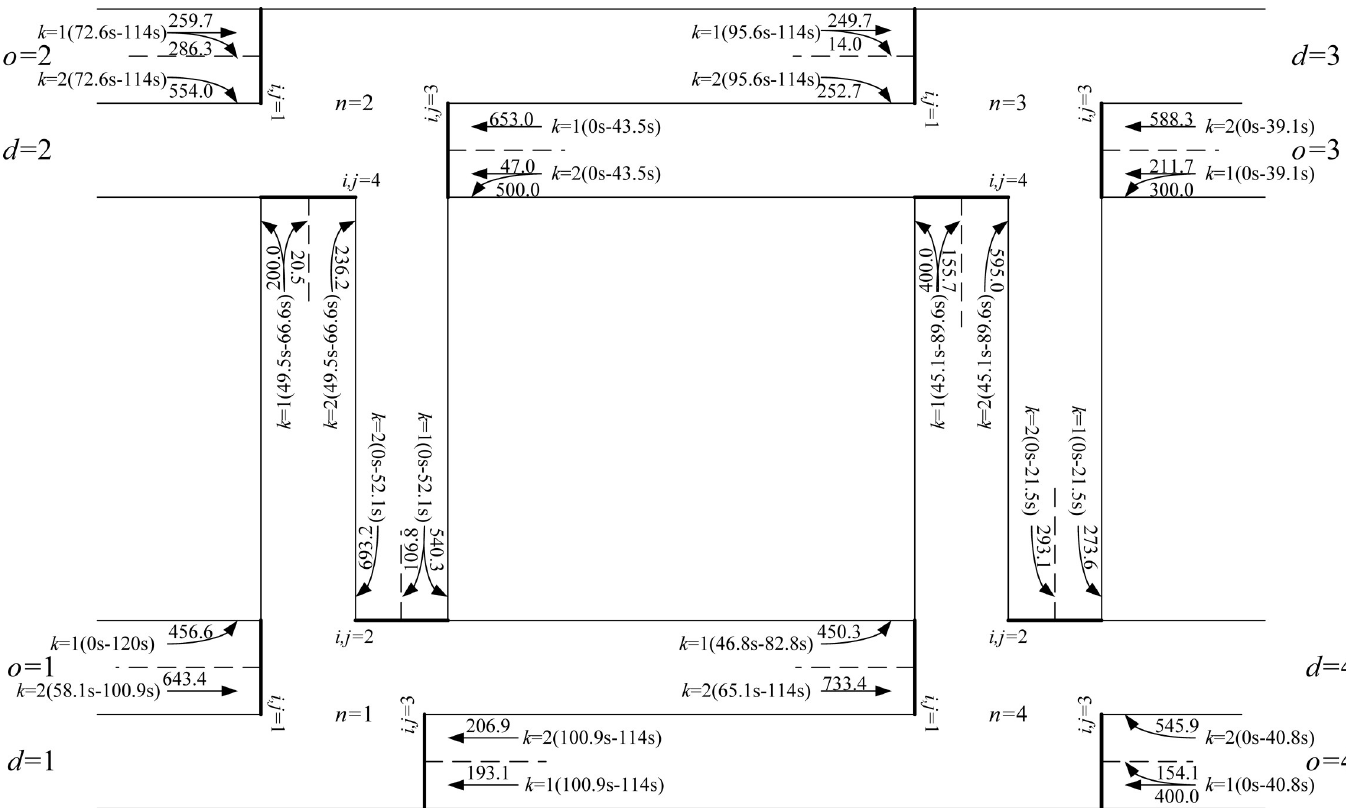
Fig 13. The optimized network configurations by maximizing the common flow multiplier m (= 1.075) with cycle length z ¼ 1 = 120 : 0 s.